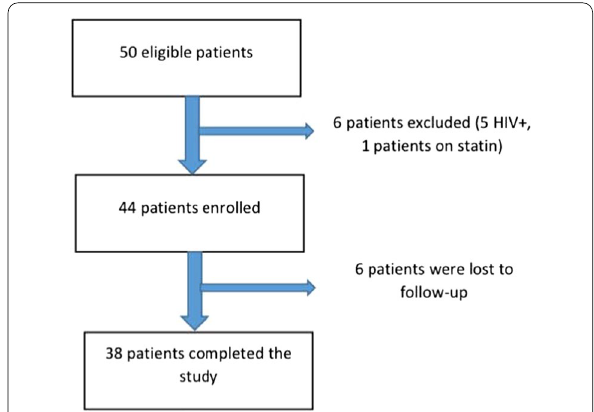
Fig. 1 Study flow diagram for patients selected